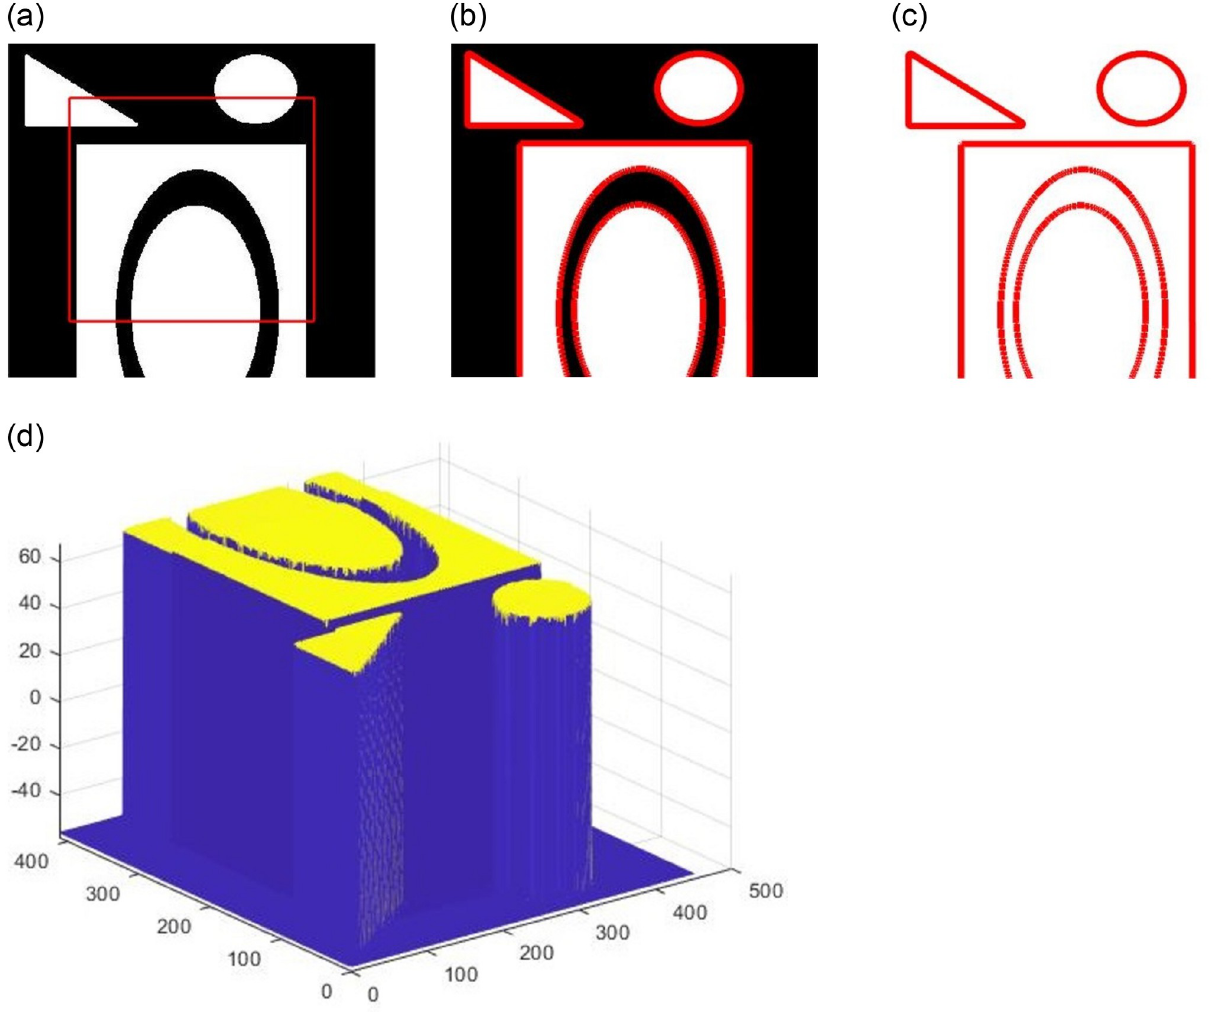
Fig 3. The segmentation results for synthetic images. (a) is the original picture with the initialization level set function, (b) is the results of the proposed segmentation method, (c) is the 0 level set function, (d) is the level set